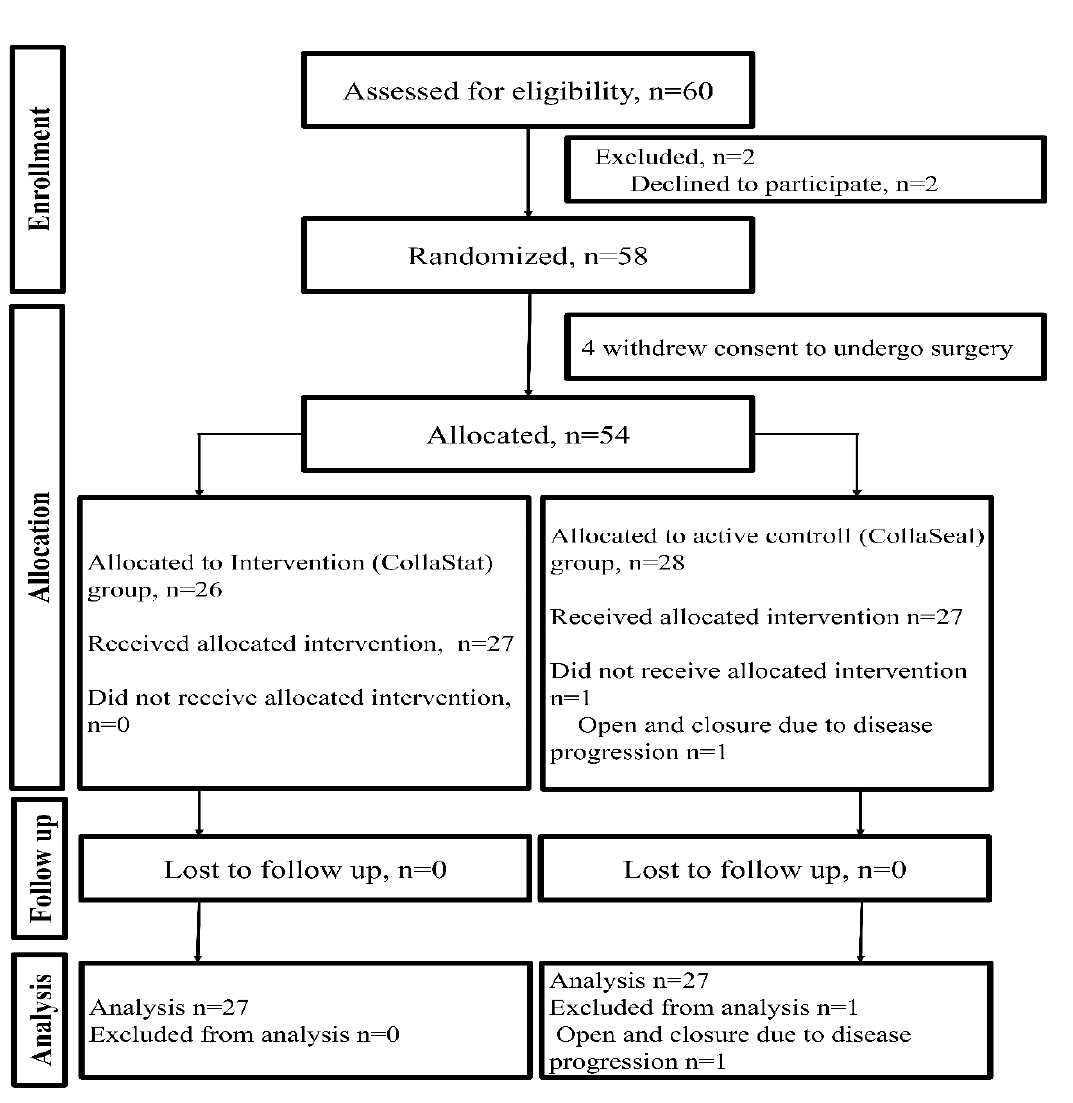
Figure 2. CONSORT flow diagram of the trial.